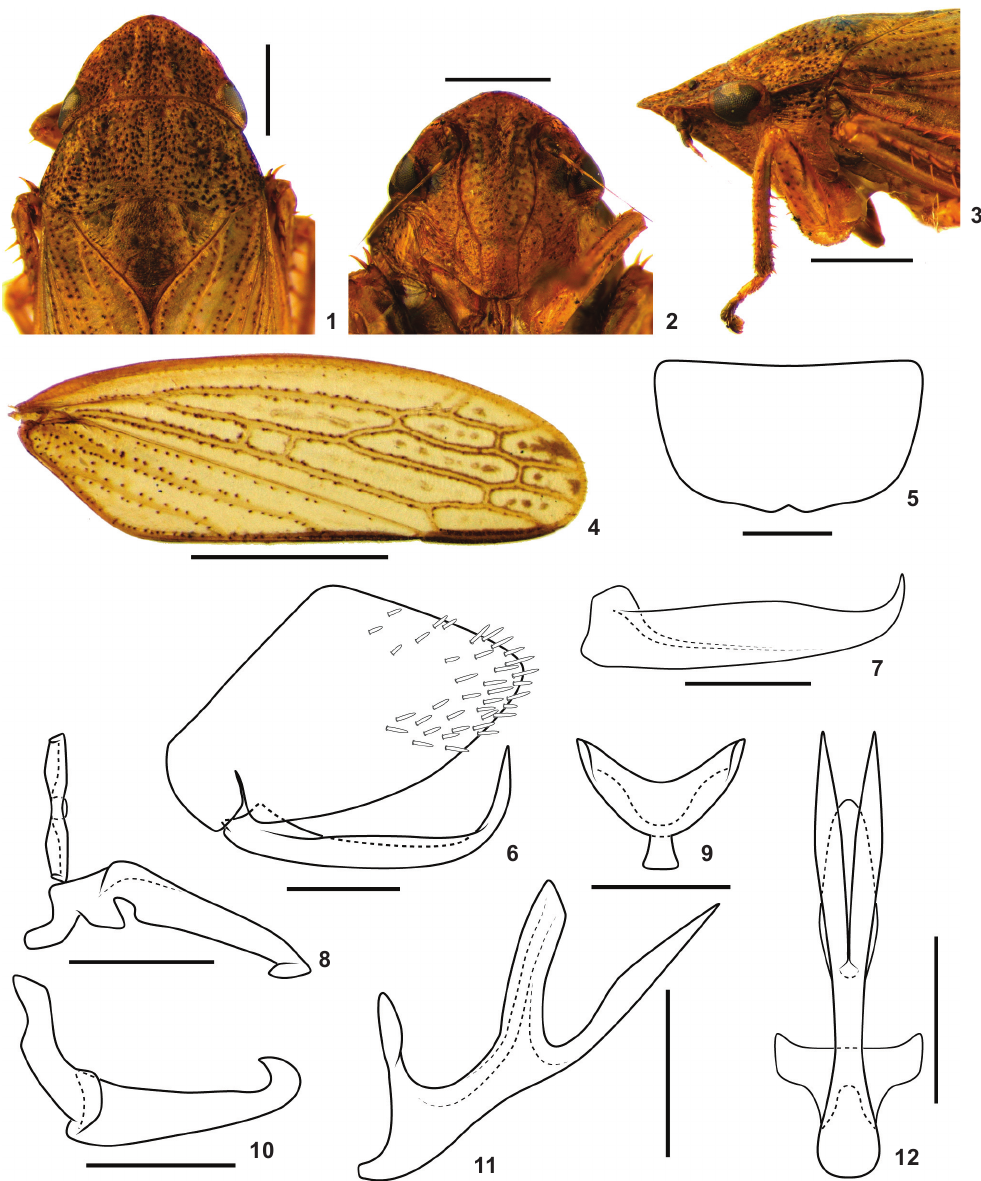
Figures 1-12. Sulcana cunicula sp. nov. , holotype male: (1) head and thorax, dorsal view; (2) head, frontal view; (3) head and thorax, lateral view; (4) forewing, dorsal view; (5) sternite VIII, ventral view; (6) pygofer and subgenital plate, lateral view; (7) subgenital plate, ventral view; (8) style and connective, dorsal view; (9) connective, posterior view; (10) style, lateral view; (11) aedeagus, lateral view; (12) aedeagus, posterior view. Scale bars: 1-3 = 1.0 mm, 4 = 2.0 mm, 5-12 = 0.5 mm.